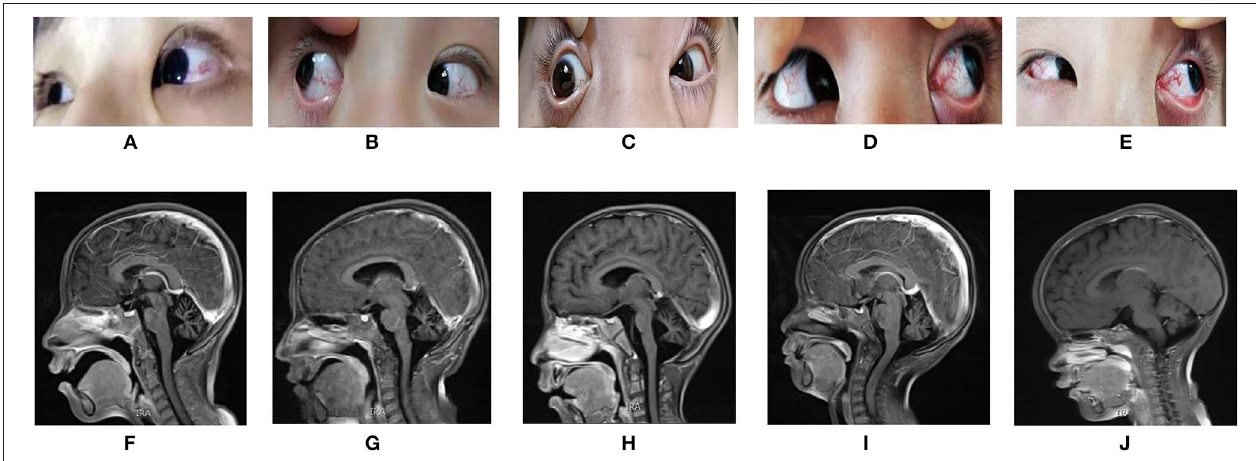
FIGURE 3 | (A–E) showed the bulbar conjunctival telangiectasia of the five AT patients; (F–J) were the pictures of the Brain MRI of the five AT patients, all showed the cerebellar atrophy. (A) and (F) are from case 1, (B) and (G) are from case 2, (C) and (H) are from case 3, (D) and (I) are from case 4, (E) and (J) are from case 5.